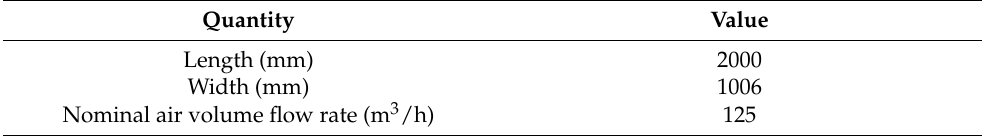
Table 1. Technical characteristics of the Solar Air Heater